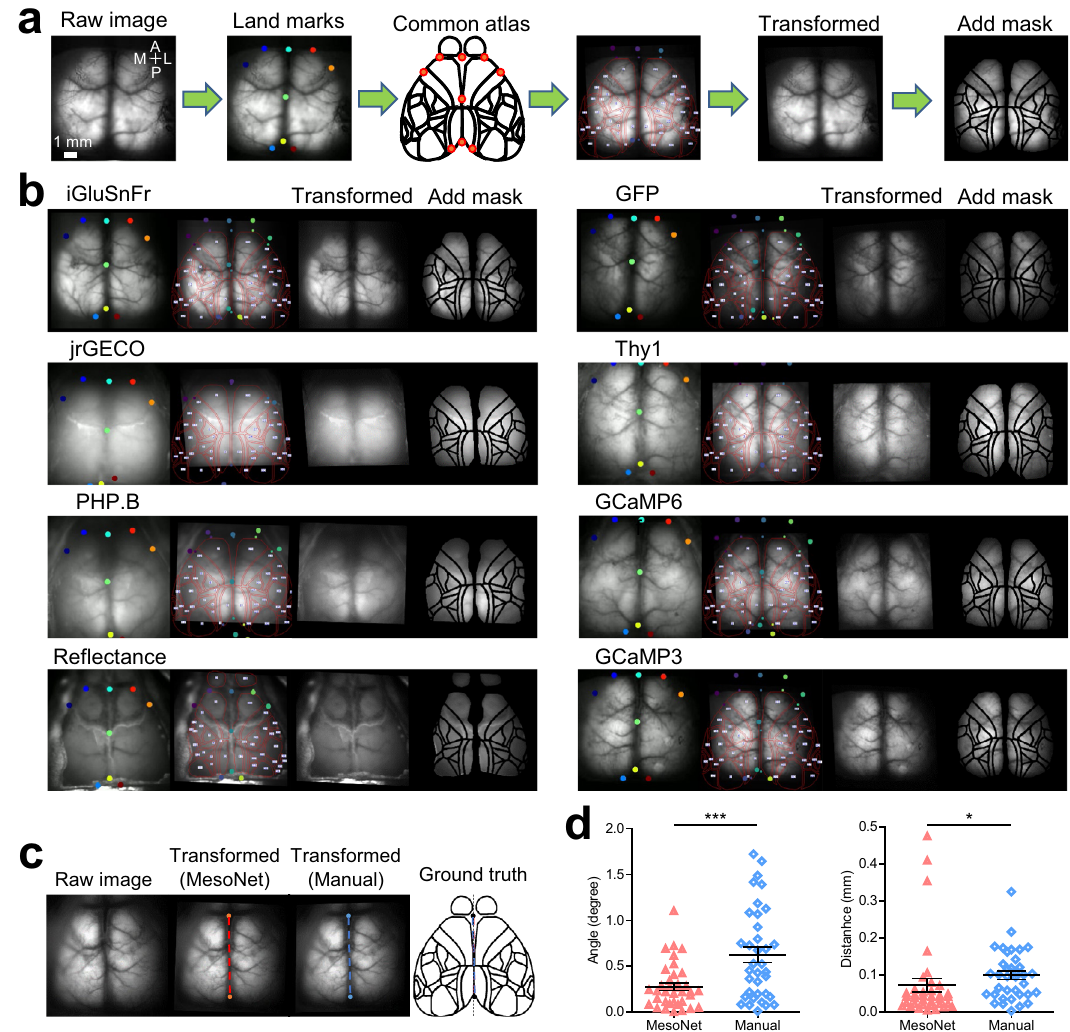
Fig. 5 Testing the brain-to-atlas approach across different lines of fl uorescent protein mice. a Automated registering and scaling pipeline of brain-to- atlas transformation (the fourth panel: big dots denote predicted landmarks on raw image, small dots denote landmarks on a common atlas, red line denote segmented brain regions; ©2004 Allen Institute for Brain Science. Allen Mouse Brain Atlas. Available from: http://mouse.brain-map.org/). b Example results of the brain-to-atlas transformation of brain image from different transgenic or virally injected mice. c Example images showing brain to atlas alignment using MesoNet or manually labelled landmarks (bregma, window margins). The performance of the alignment is based on the calculation of the distance between landmarks of anterior tip of the interparietal bone and cross point between the median line and the line which connects the left and right frontal pole, and angle of the midline compared to the ground truth common atlas, and angle of the midline compared to the ground truth common atlas (all distances and angles are reported as positive deviations compared to ground truth common atlas). d Distribution of the angle (scatter dot plot, line at mean with SEM, *** p values < 0.001, * denote p values <0.05; MesoNet, mean ± SEM = 0.28 ± 0.04; Manual, mean ± SEM = 0.62 ± 0.08; Wilcoxon signed-rank test, Two-tailed, p = 0.0005, Sum of signed ranks (W) = − 446, n = 36 mice) and dista n ce (MesoNet, mean ± SEM = 0.07 ± 0.02; Manual, mean ± SEM = 0.1 ± 0.01; Wilcoxon signed-rank test, Two-tailed, p = 0.0122, Sum of signed ranks (W) = − 320, n = 36 mice). MesoNet performs signi fi cantly better in both comparisons. Source data are provided as a Supplementary Data fi